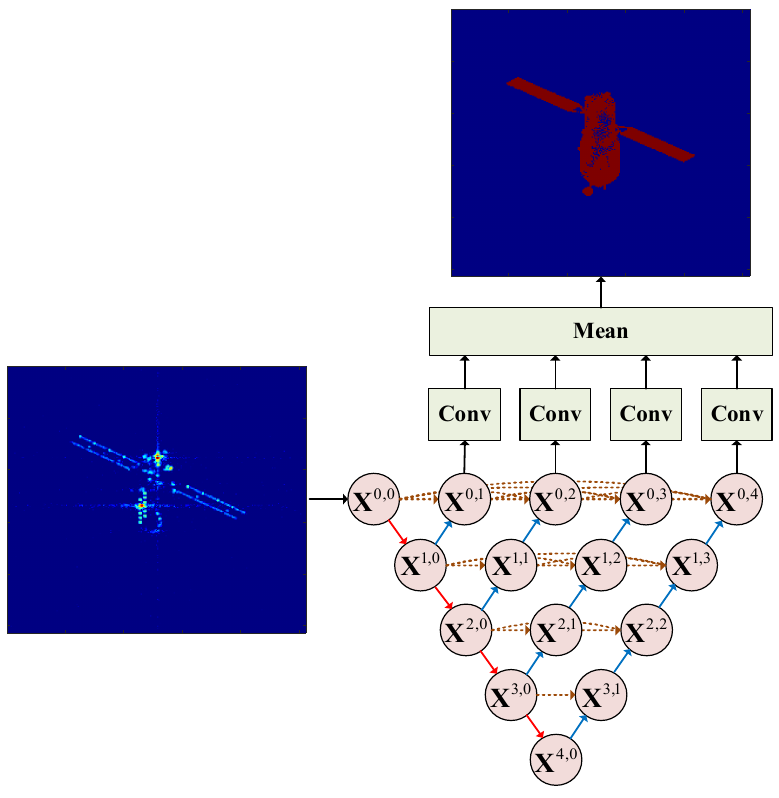
Figure 6. Flow chart of ISAR image enhancement based on UNet++.